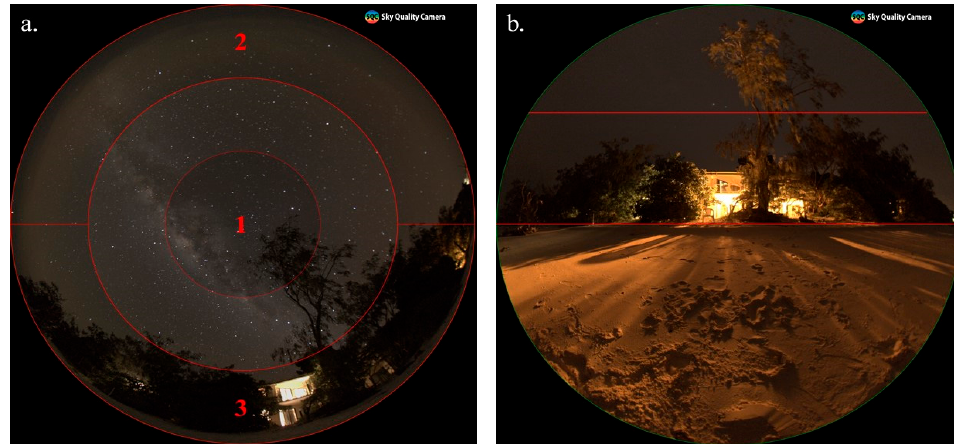
Figure 6. ( a ) Zenith photograph taken on the night of 13 May 2018 at sampling site 4 Heron Island, Australia. This image depicts the three sectors classified for sky quality camera brightness analysis: 1. Sky Quality Meter sector, 2. Seaward cone of acceptance sector, 3. Landward cone of acceptance sector. ( b ) Horizontal landward photograph taken on the night of 20 June 2018 at sampling site 4 Heron Island, Australia. This image depicts the COA sector classified for sky quality camera brightness analysis.